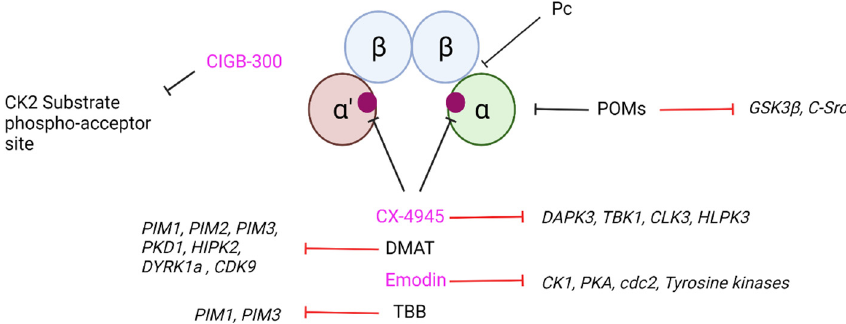
Figure 5. Summary of popular CK2 inhibitors, target sites and off-target effects. Several examples of available CK2 inhibitors with the sites of action are indicated in the figure. Inhibitors that have been used in or are currently in clinical trials are indicated with pink text, CX-4945, CIGB-300, and Emodin [147]. The example CK2 holoenzyme is a tetrameric form with 2-beta subunits (blue), one alpha subunit (green; right) and one alpha’ subunit (maroon; left). ATP binding sites are indicated by purple circles within the catalytic subunits. Off target effects of the inhibitors are indicated with red arrows [136,139,209,218–221]. Created with Biorender.com (accessed 29 June 2022).